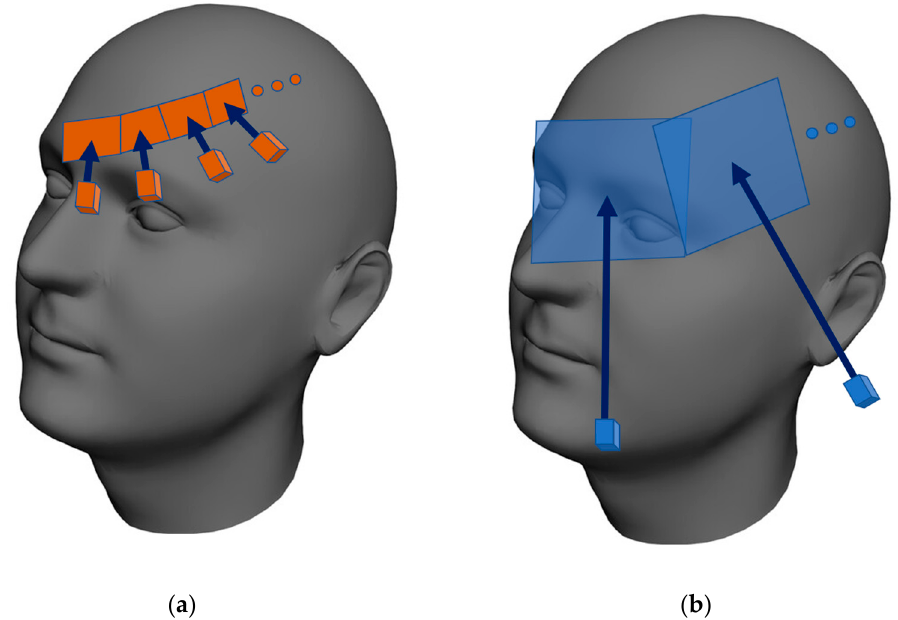
Figure 5. The procedures of reaching the same resolution rates in all of the spectral layers despite the native resolution of the sensors differ significantly: ( a ) hundreds of thermal images are captured at a very short distance, yielding a high resolution in a single image; the range, however, is narrow. Multiple images are taken and then merged by mapping onto the surface to form a single, high-resolution layer covering the whole model; ( b ) the native resolution of the color camera is markedly higher, meaning that only several images taken at a greater distance are needed to reach the final resolution identical with that achieved in scenario ( a ).